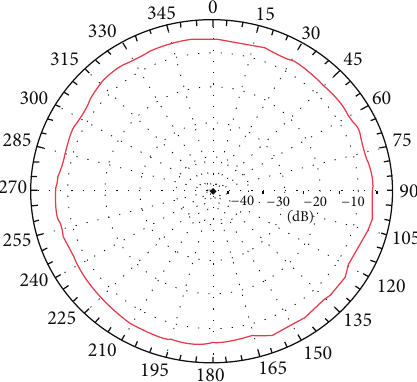
Figure 11: Horizontal cut of 3D measured radiation pattern at 8 GHz.